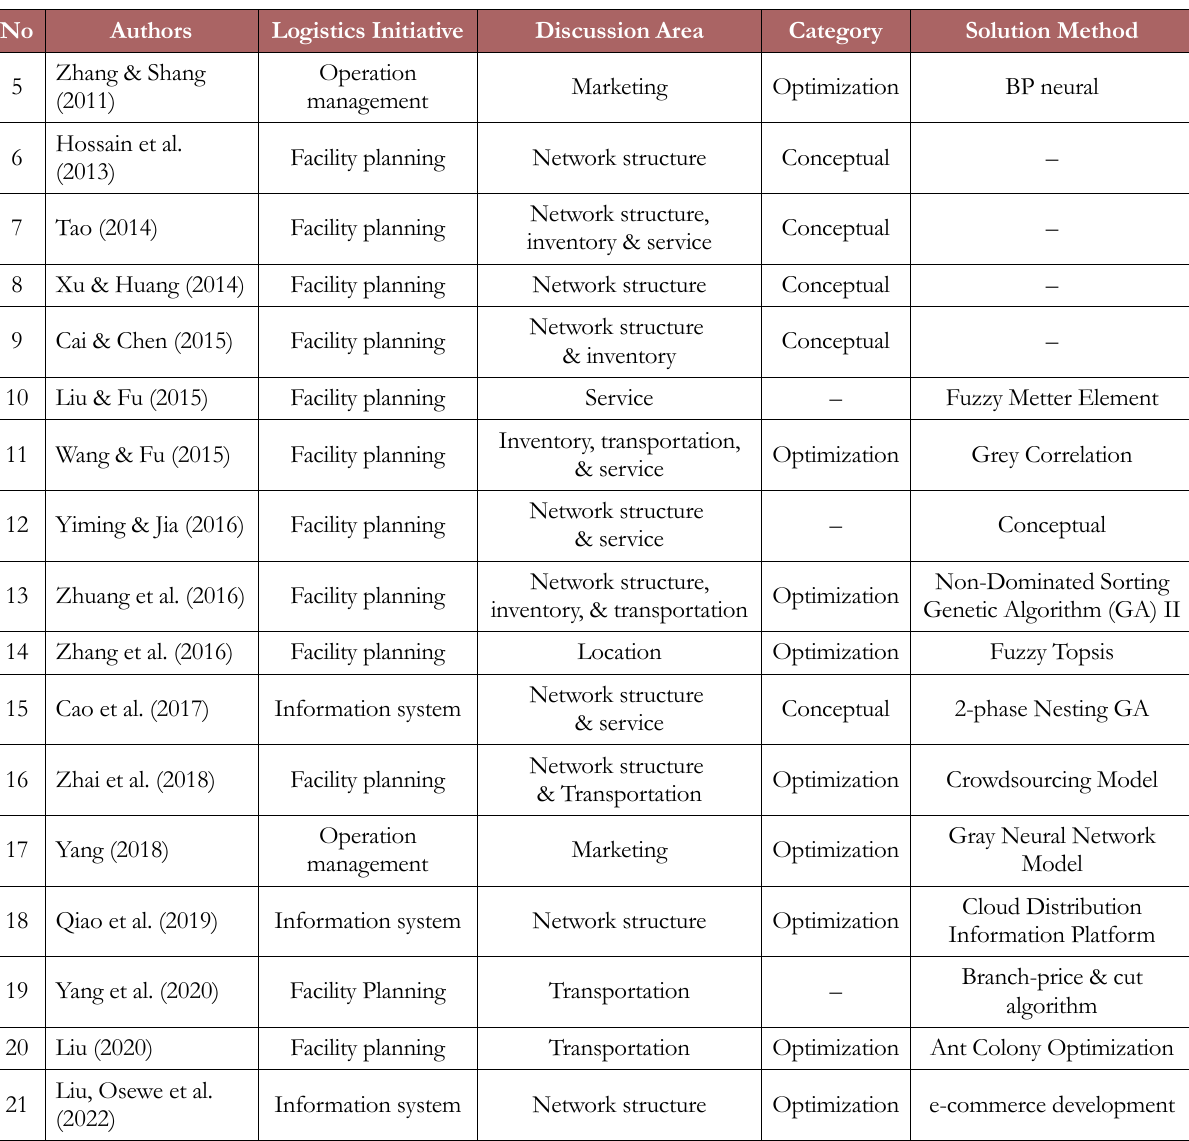
Table 2. Study developments related to rural